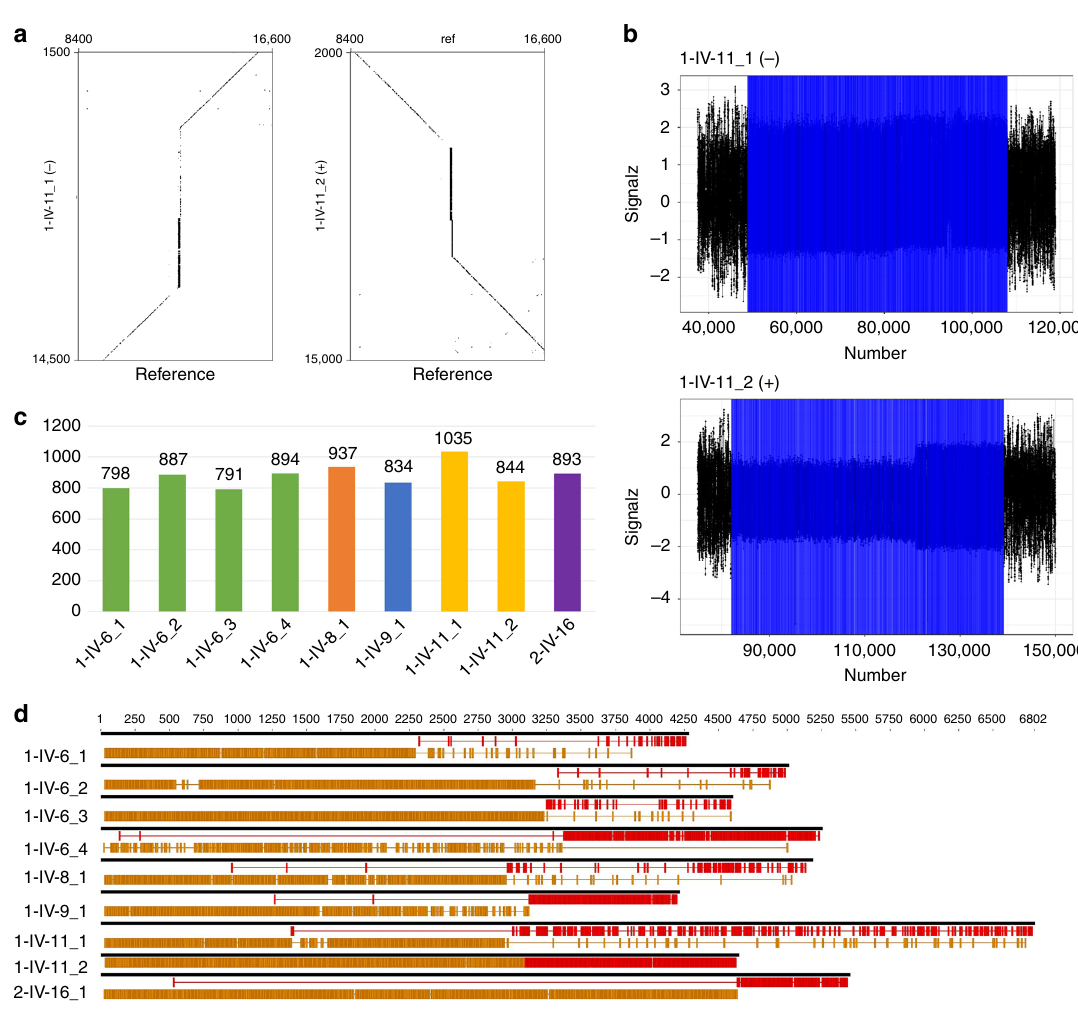
Fig. 3 Characterization of MARCH6 expansions by Nanopore sequencing. a Dot plots comparing two nanopore reads from individual 1-IV-11 displaying the expansion ( Y -axis, scale: 13 kb) with the corresponding hg19 reference region ( X -axis, scale: 8.1 kb). The expansions appear as vertical lines. Read 1-IV-11_1 is on the negative strand while read 1-IV-11_2 is on the positive strand. b Analysis of the same raw nanopore reads using NanoSatellite. The signals corresponding to the expanded repeats appear in blue. c Number of total repeats inferred by NanoSatellite for each extracted read covering the expansion. Data are displayed for the fi ve individuals for whom reads covering the whole expansion have been detected. Four reads covering parts of the expansion and fl anking regions were obtained for individual 2-IV-9 but are not included in this graph. Dot plots and raw nanopore reads covering completely the expansion appear in Supplementary Fig. 6 and all sequences are available in Supplementary Data 3. d Schematic representation of the sequence of the same nanopore reads showing exact TTTTA motifs in yellow and exact TTTCA motifs in red. Gaps between exact repeats possibly correspond